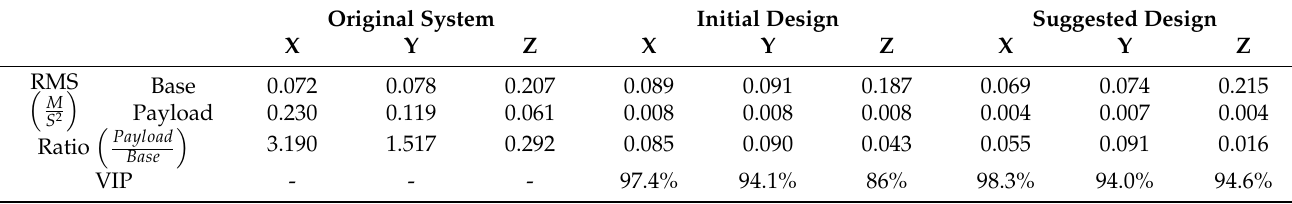
Table 4. Comparison of the root-mean-square (RMS), the ratio between a payload and base, and vibration isolation performance (VIP) in the frequency range of 30–85